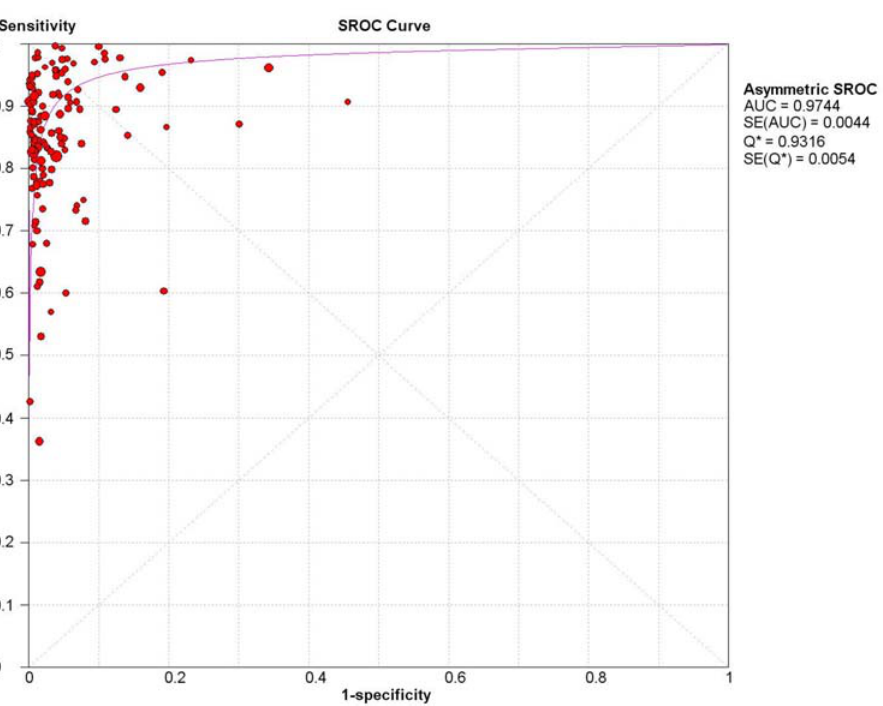
Figure 4. SROC plot with best-fitting asymmetric curve. Each solid circle represents each study in the meta-analysis. The curve is the regression line that summarizes the overall diagnostic accuracy. SROC=summary receiver operating characteristic; AUC=area under the curve; SE(AUC)=standard error of AUC; Q*=an index defined by the point on the SROC curve where the sensitivity and specificity are equal, which is the point closest to the top-left corner of the ROC space; SE(Q*)=standard error of Q* index.